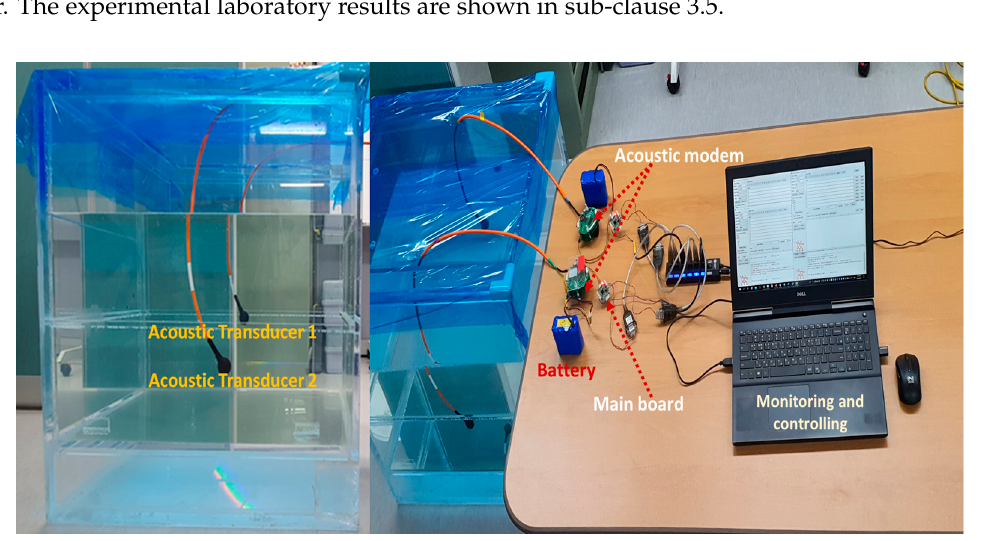
Figure 16. Testbed setup of U-NMS in a laboratory environment.